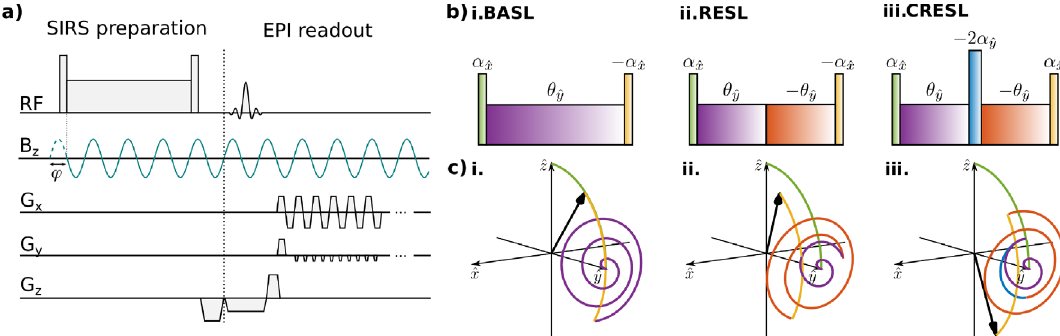
Figure 1. Pulse sequence, SL preparations and magnetization dynamics. ( a ) Pulse sequence diagram for a conventional SIRS preparation (BASL) followed by an echo planar imaging (EPI) acquisition. An exemplary oscillating target field ( B z ) is shown, the initial phase ( ϕ ) corresponds to the phase at the beginning of the SL pulse. ( b ) RF pulses that define the three SL preparations studied in this work: (i) basic SL preparation (BASL), (ii) rotary echo SL pulse (RESL) and (iii) composite rotary echo SL pulse (CRESL). ( c ) Representative diagram of the magnetization dynamic for the SL preparations showed in ( b ) when in the presence of a resonant oscillating field applied along ˆ z . The trajectory is color-coded to differentiate the effect of each RF